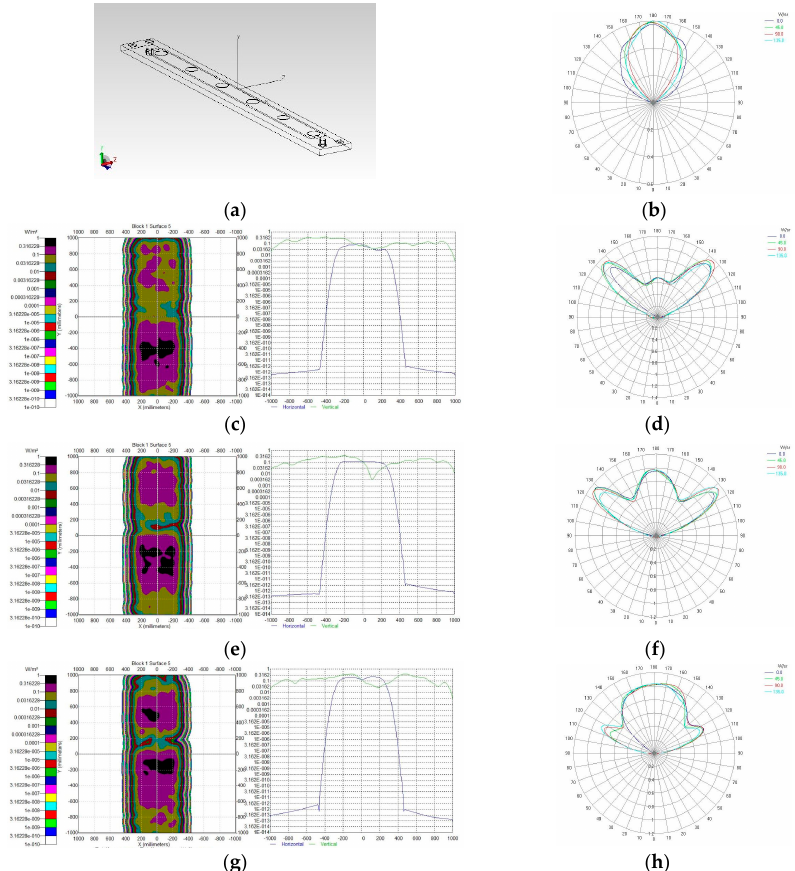
Figure 4. UV LED light bar, and simulated illuminance distribution and intensity distributions of